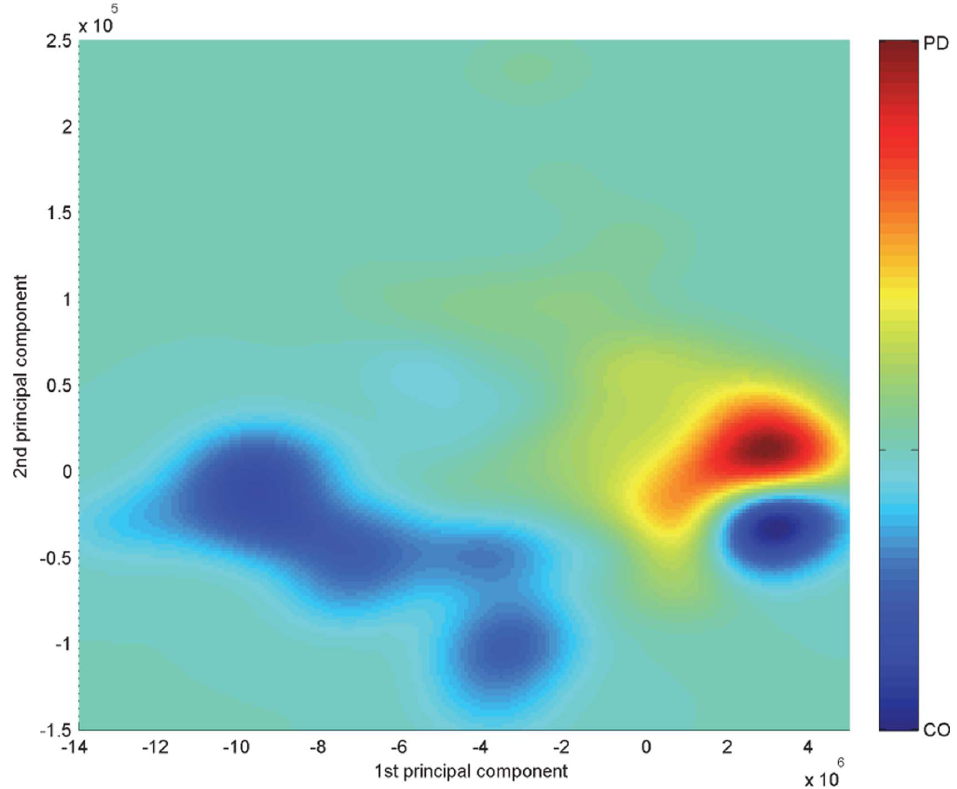
Figure 3. Bivariate distributions of vocal patterns in the kernel principal component analysis (KPCA) mapping feature plane. Vocal pattern distributions for the healthy controls (CO) and patients with Parkinson’s disease (PD) are displayed with the cold color map (blue for the highest density) and hot color map (red for the highest density), respectively.